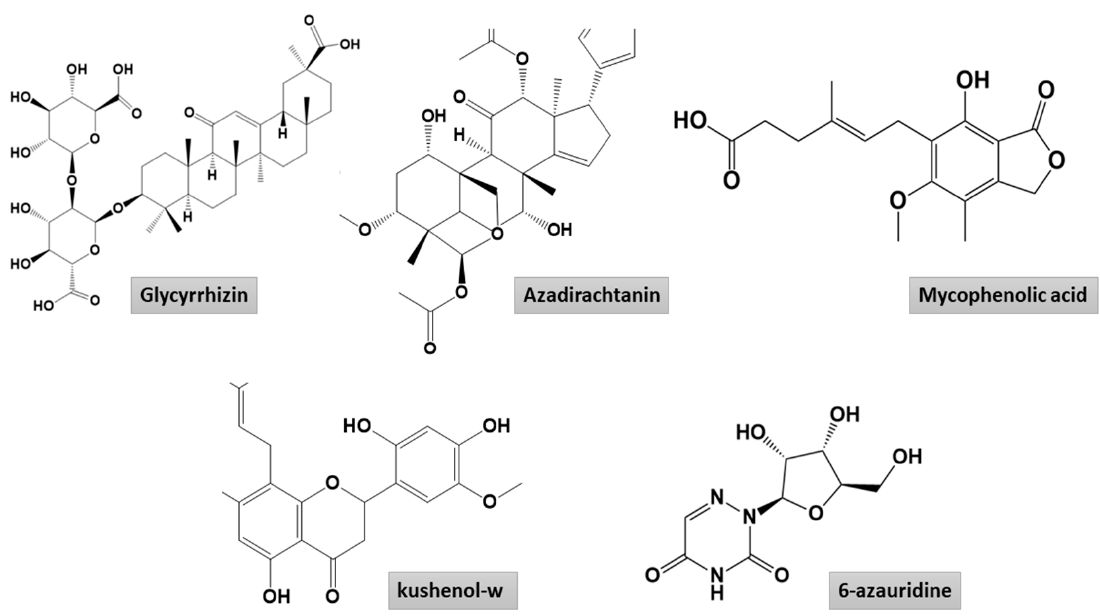
Figure 3. Two-dimensional presentation of high affinity binders to the SARS-CoV-2 proteins.